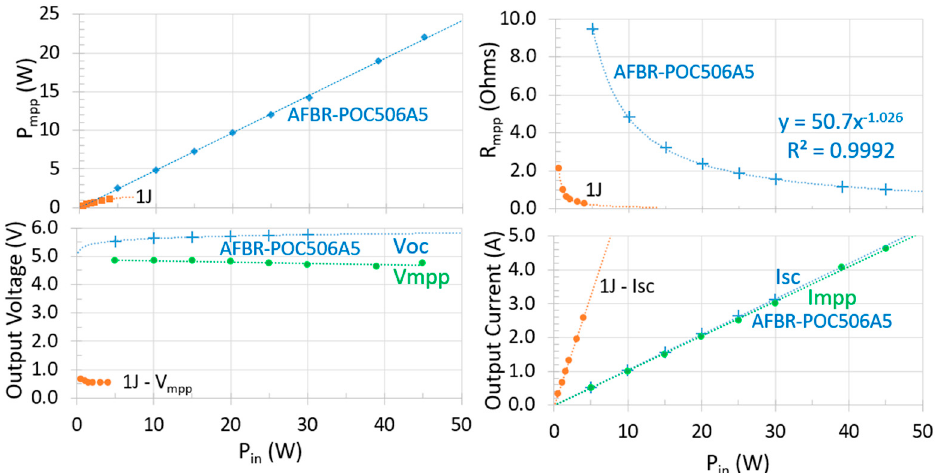
Figure 9. Input power dependence of the key performance parameters of the high ‐ power PT6 OPC (Broadcom’s AFBR ‐ POC506A5) at an input laser wavelength of ~ 977 nm at T = 23 °C. The results for a 1J InGaAs OPC measured at 977 nm are also shown for comparison (orange curves). The OPCs’ active areas are 1 cm 2 in all cases.